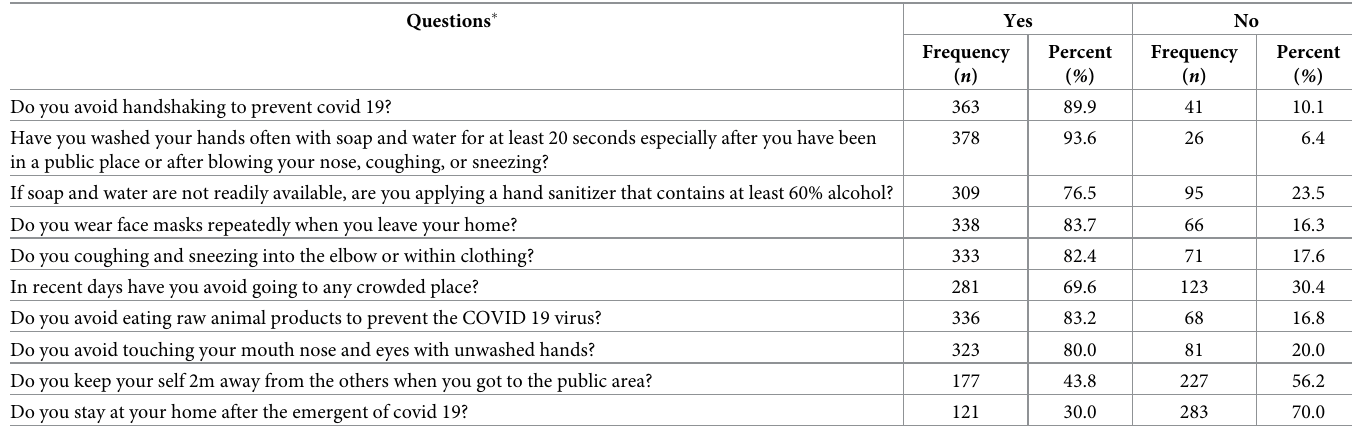
Table 4. Preventive practice of adult visitors towards COVID-19 prevention in hospitals of South Gondar zone, Northwest Ethiopia, August 1 to 30, 2020. Questions